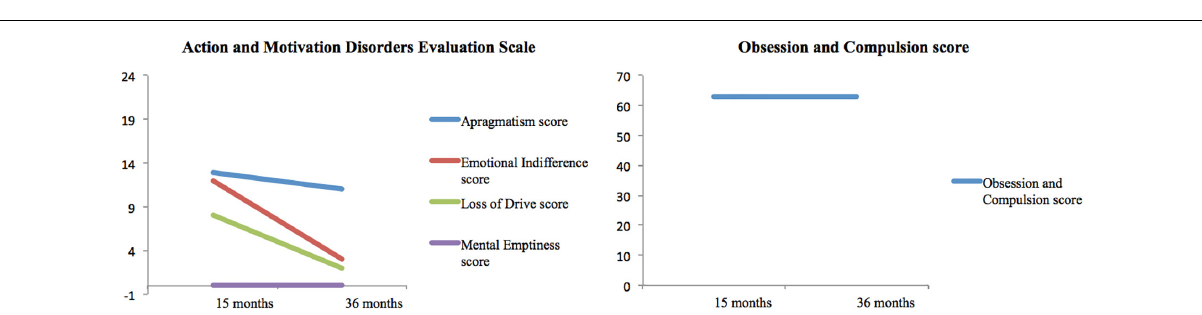
FIGURE 2 | 3D volume rendering of basal ganglia lesion. The lesion is represented in red. Green: putamen, blue: caudate nucleus, yellow: ventral striatum, light blue: dorsal pallidum, purple: ventral pallidum. Lower row: lateral view of the left (L) and right (R) globus pallidus and striatum. Note the predominance of the lesion in the anterodorsal part of the striatum.